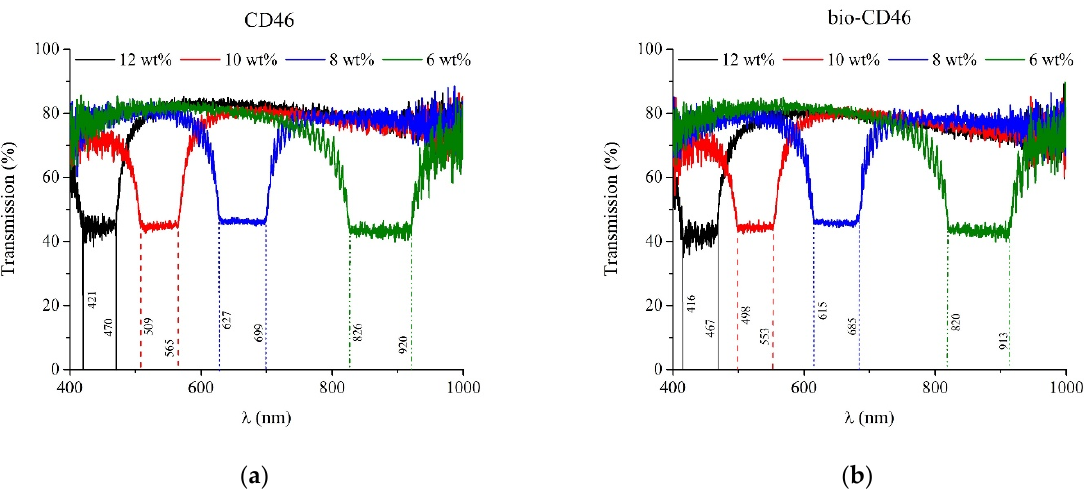
Figure 3. Transmission measurements of ( a ) CD46 and ( b ) bio-CD46 mixtures of concentrations of 12 wt.%, 10 wt.%, 8 wt. %, and 6 wt.% in E7 showing the bandgap width location for each concentration. Table 2. Refractive indices for different concentrations of CD46 and bio-CD46 mixtures in E7. Values were calculated using measured pitch and band edge location. CD46 bio-CD46 C (wt. %)